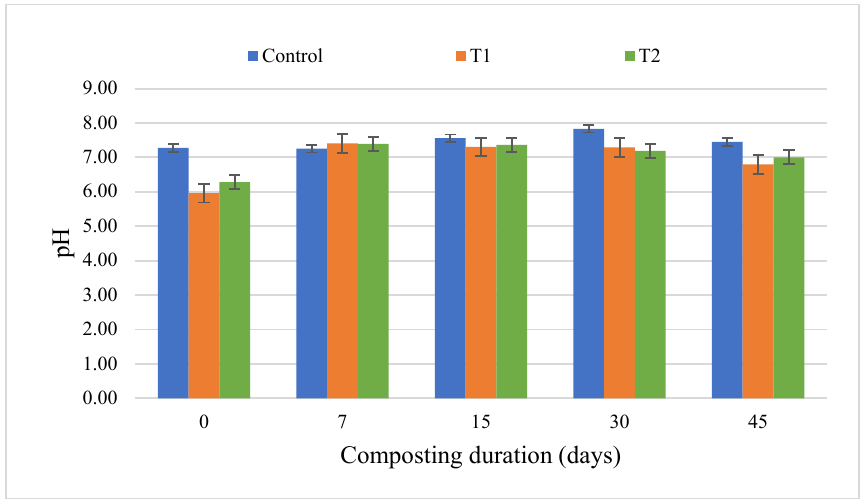
Figure 5. The pH of the control, T1, and T2 samples at 0, 7, 15, 30, and 45 days.